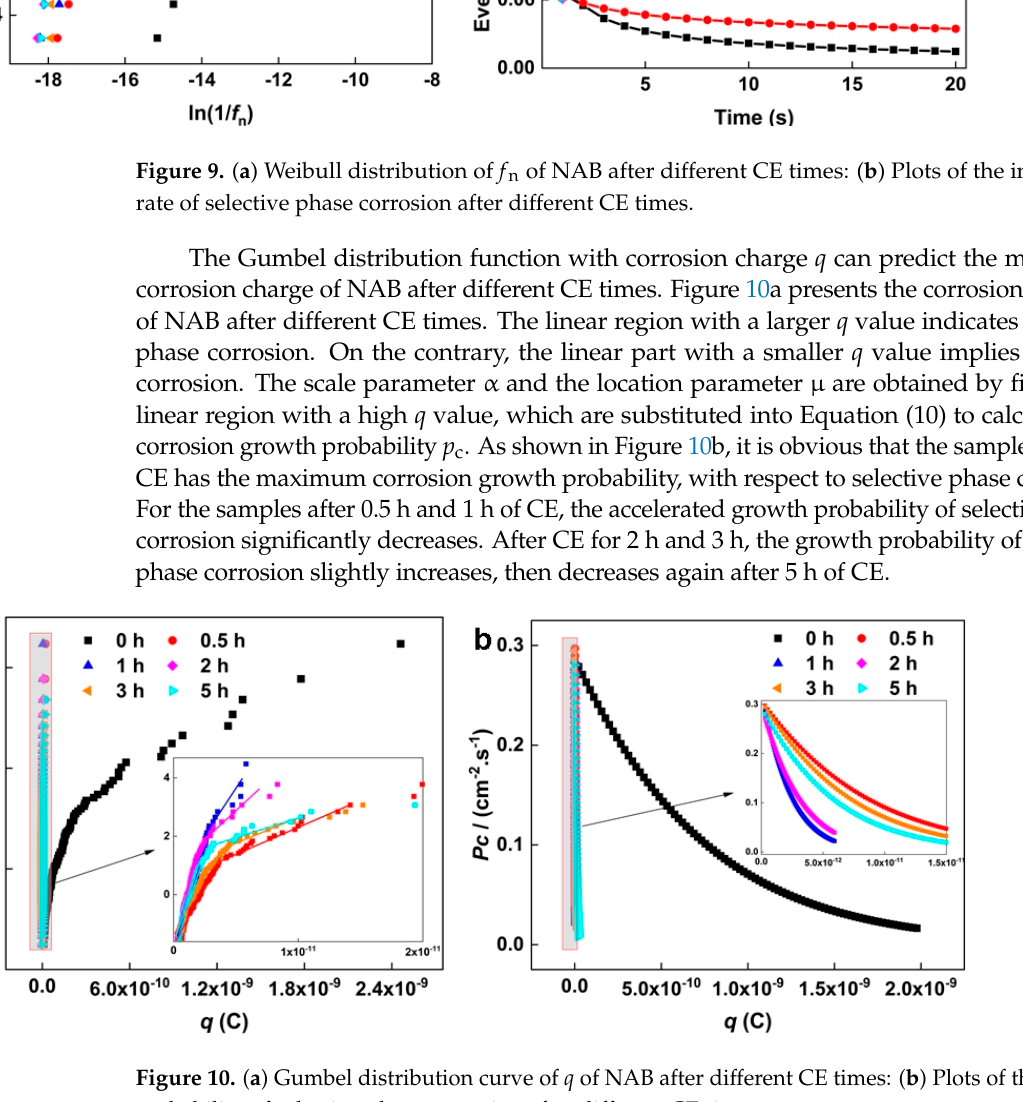
Figure 10. ( a ) Gumbel distribution curve of q of NAB after different CE times: ( b ) Plots of the growth probability of selective phase corrosion after different CE